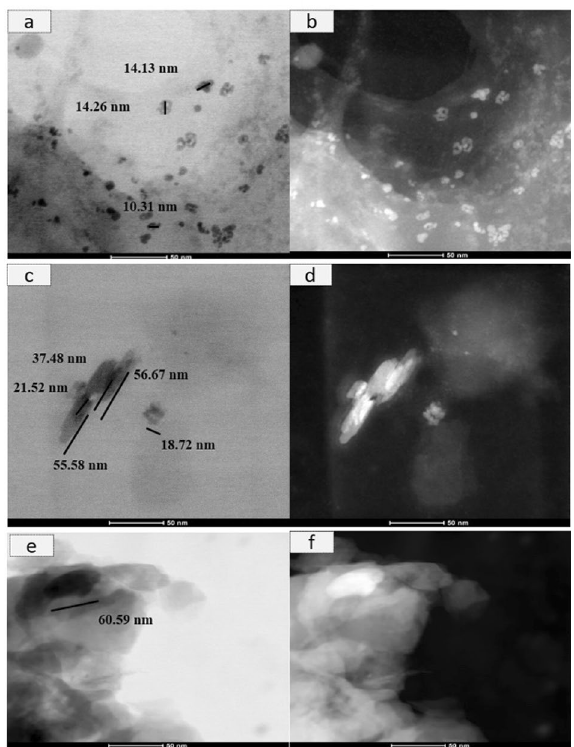
Figure 6. MET (magnification) of nanoparticles: brightfield ( a (320,000×), c (450,000×), and (450,000×)) MMT, GO and hybrid GO/MMt and darkfield ( b (320,000×), d (450,000×), f (450,000×)) MMT, GO and MMT/ GO hybrid.